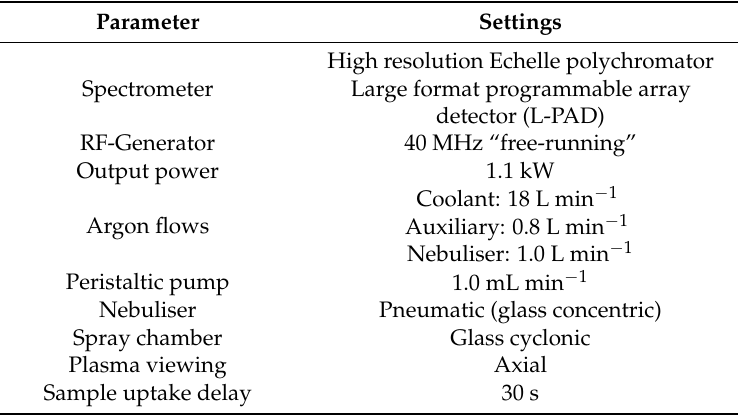
Table 1. Operating conditions of the Prodigy High Dispersive